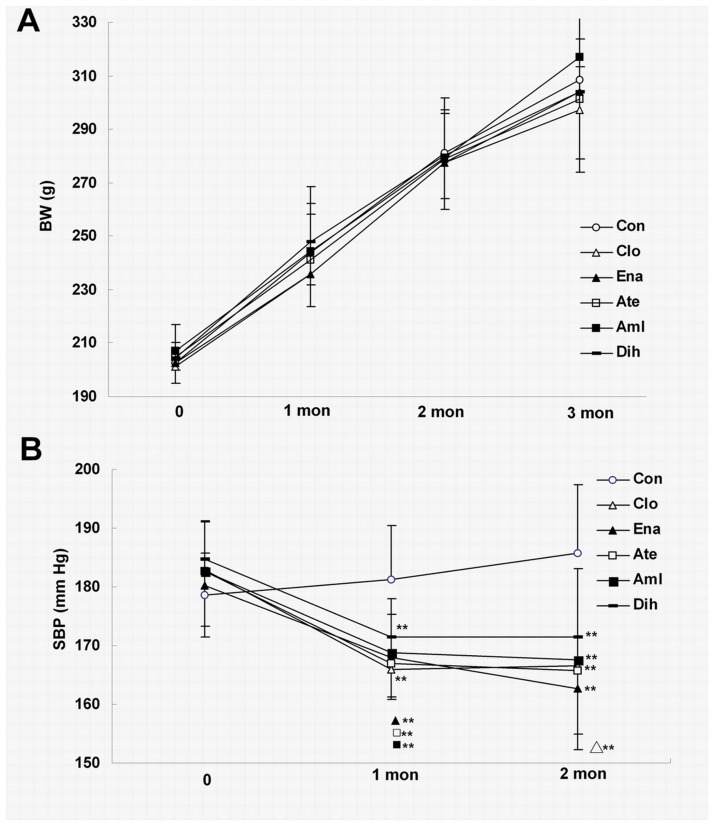
Effect of 3-month treatment of 5 antihypertensive drugs on the body weight and SBP level of SHR.The changes of body weight (A) and SBP level (B) during 3-month treatment of 5 antihypertensive drugs. Data are shown as mean ± SD and analyzed by ANOVA followed by dunnett t-testing. **P<0.01 vs. control. Abbreviation: BW, body weight; Con, control; Clo, clonidine; Ena, enalapril; Ate, atenolol; Aml, amlodipine; Dih, dihydrochlorothiazide.